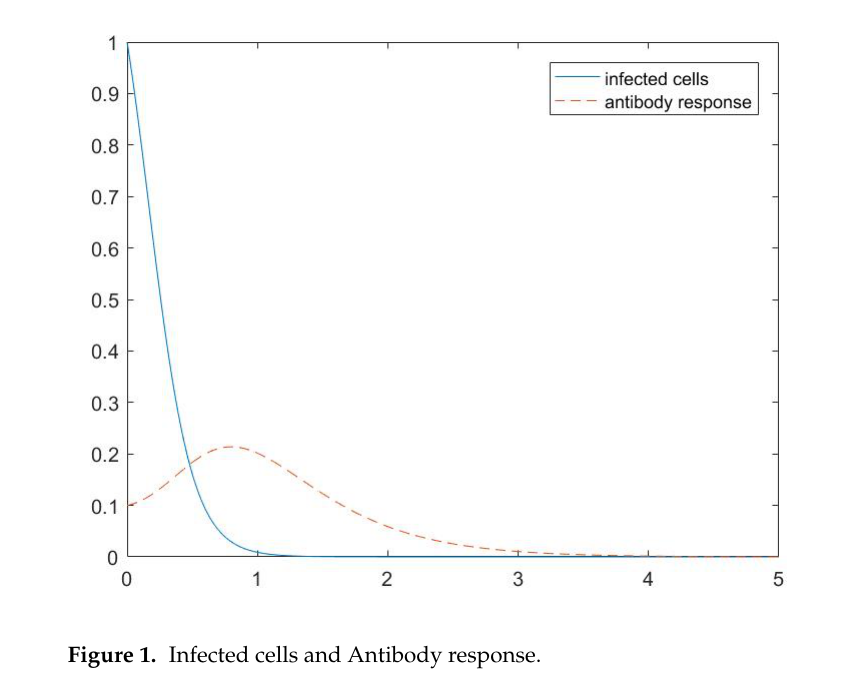
Figure 1. Infected cells and Antibody response.